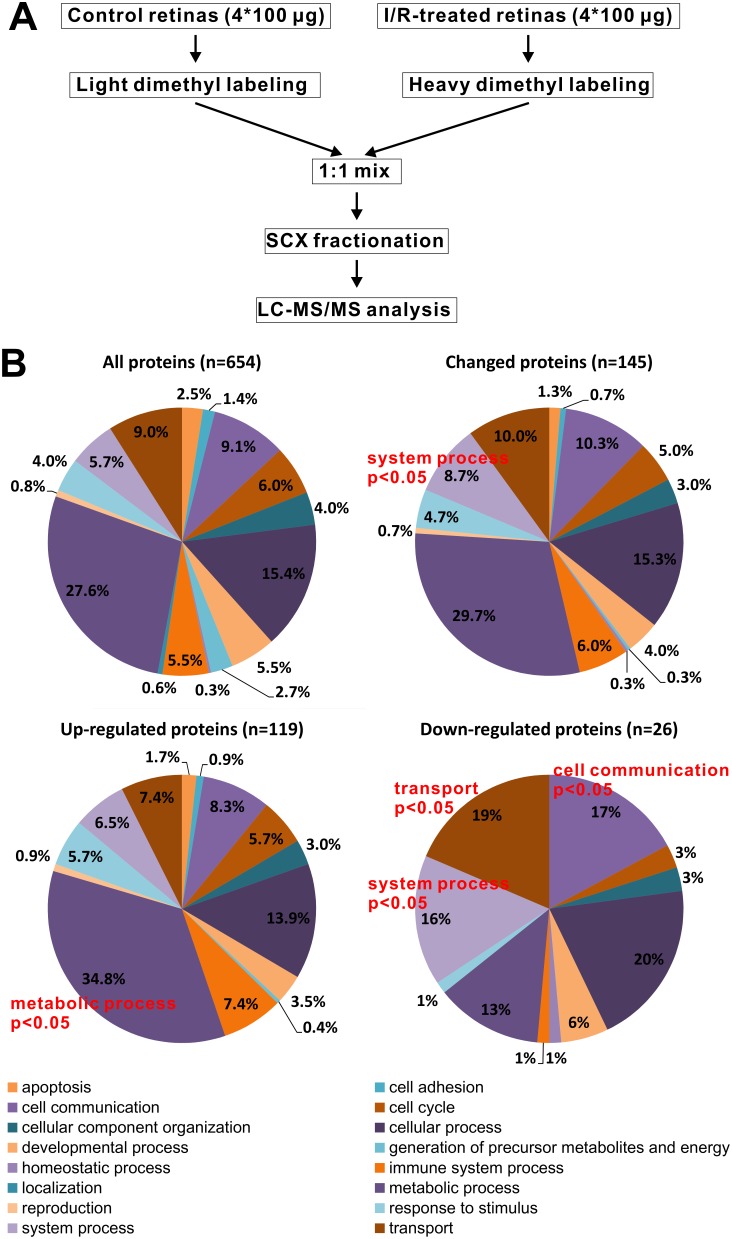
Experimental strategy and data overview.A, Workflow of the dimethyl labeling-based quantitative proteomics analysis, comparing the retinal proteome before and after the I/R treatment; B, The Gene Ontology analysis of biological process. The GO analysis was performed with the PANTHER 8.1 classification system. Upper left, GO classification of the total quantitative proteins as a background; Upper right, GO classification of all of the altered proteins; Down, GO classification of the up-regulated and down-regulated proteins following the retinal I/R injury. P<0.05 represents an enriched category.